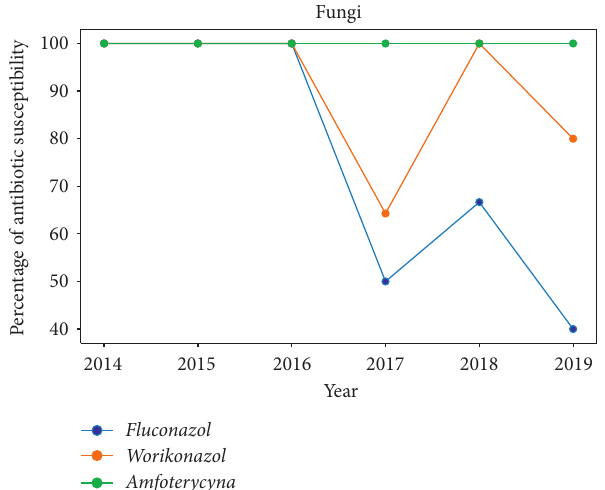
Figure 15: Percentage of antibiotic